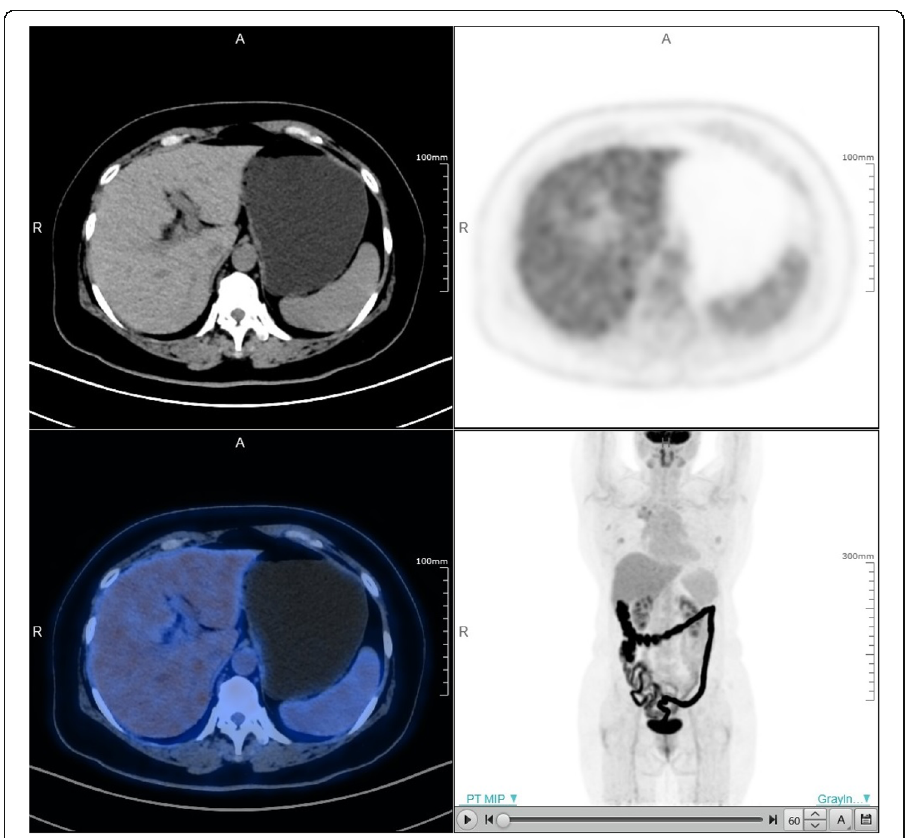
Fig. 7 Third patient images, upper left is CT image, upper right is PET image, lower left is PET/CT fusion image, and lower right is MIP image